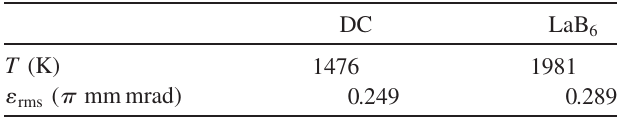
TABLE III. Transverse emittance of DC and LaB